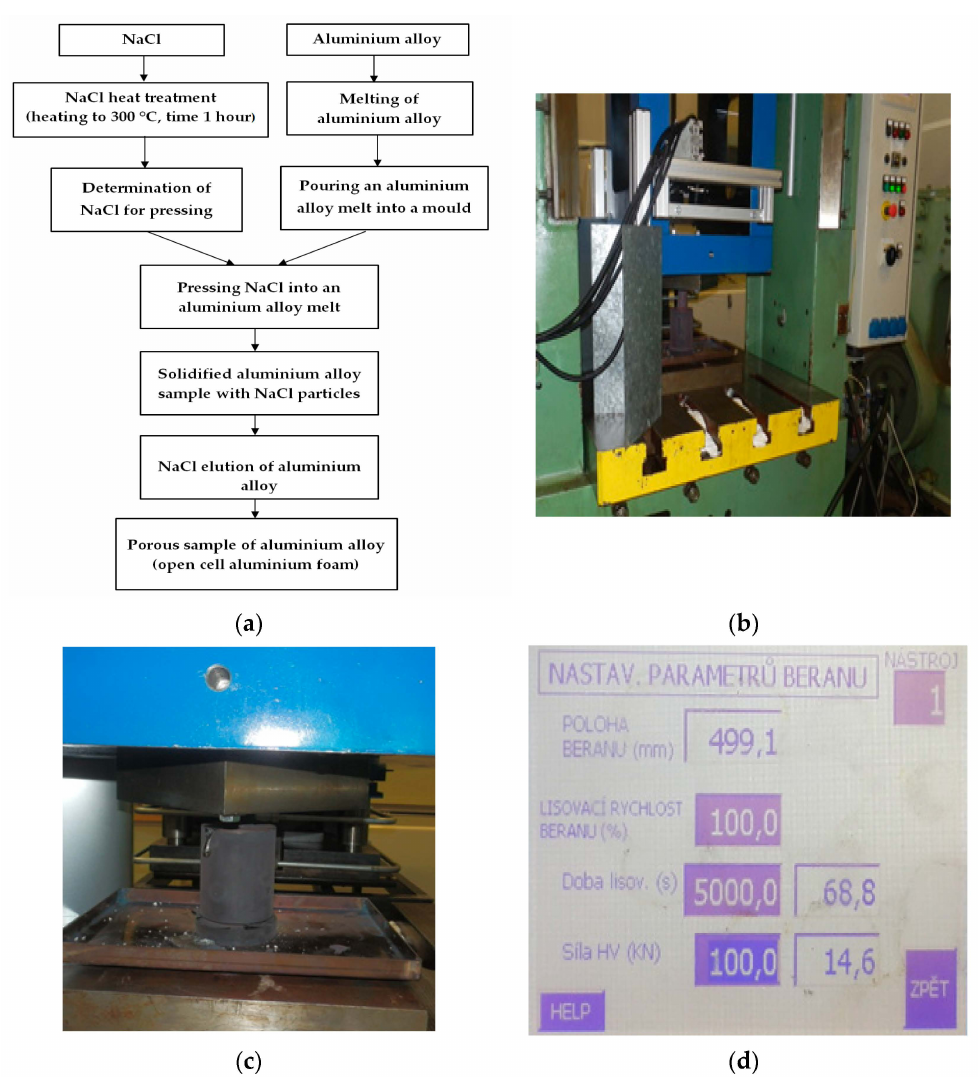
Figure 4. ( a ) Scheme of production porous materials. ( b ) View of the hydraulic press. ( c ) Detailed view of the foundry mould with NaCl pressing and ( d ) its monitor with the settings of the required presses values (position of the press ram: 499.1 mm; pressing speed of the ram: 100; pressing time: 5000 s; pressing force: 100